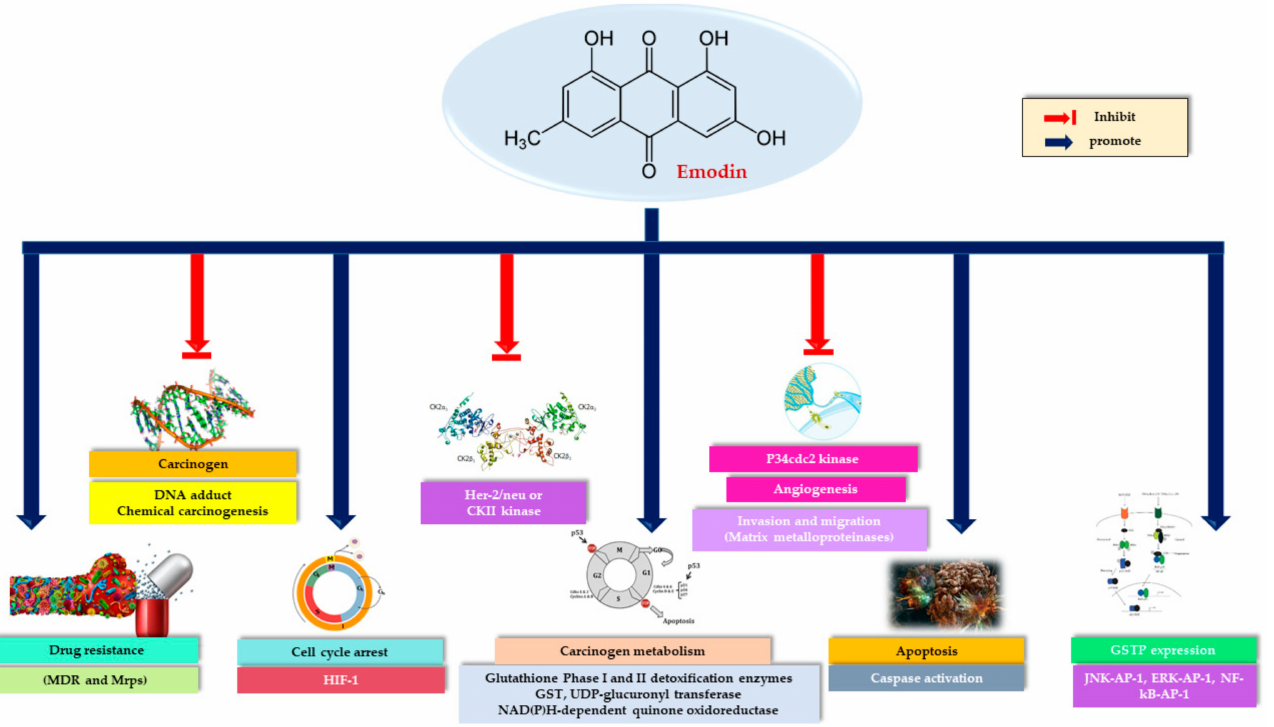
Figure 1. An overview of emodin’s anticancer